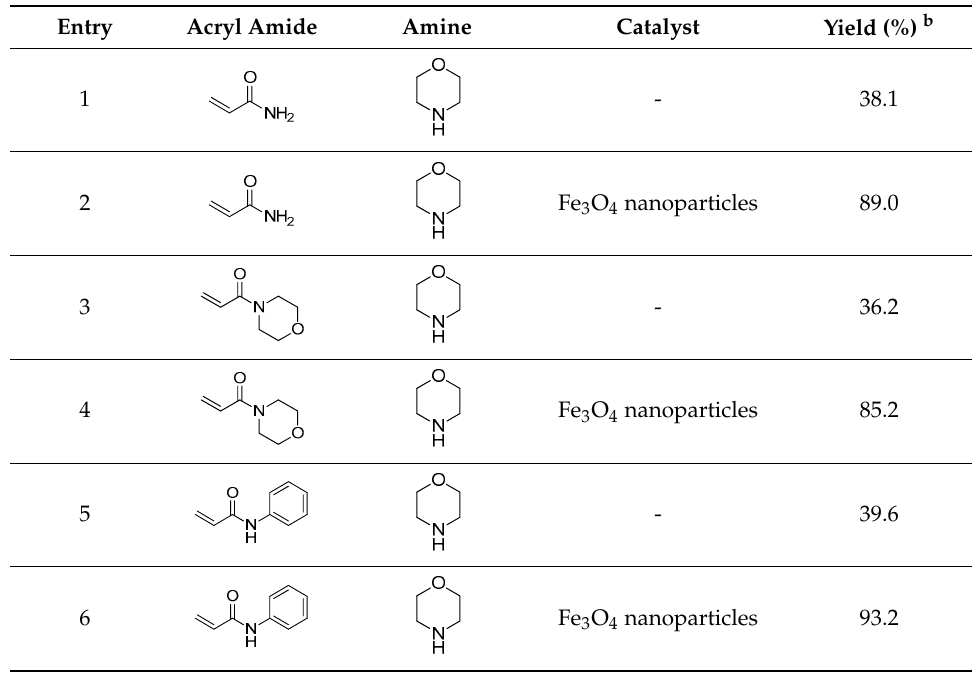
Table 1. Influence of the Fe 3 O 4 nanoparticles on the aza ‐ Michael addition of various substituent on N position of acryl amides with morpholine. a